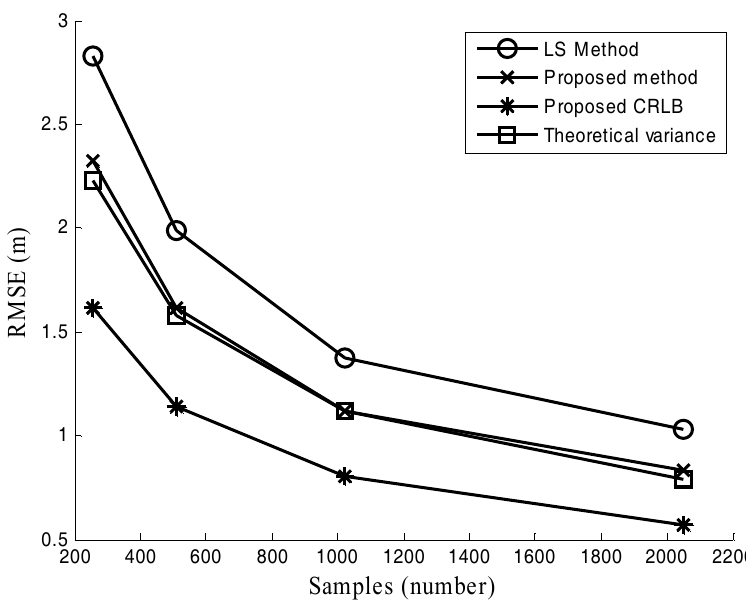
Figure 8. Positioning error under different M.